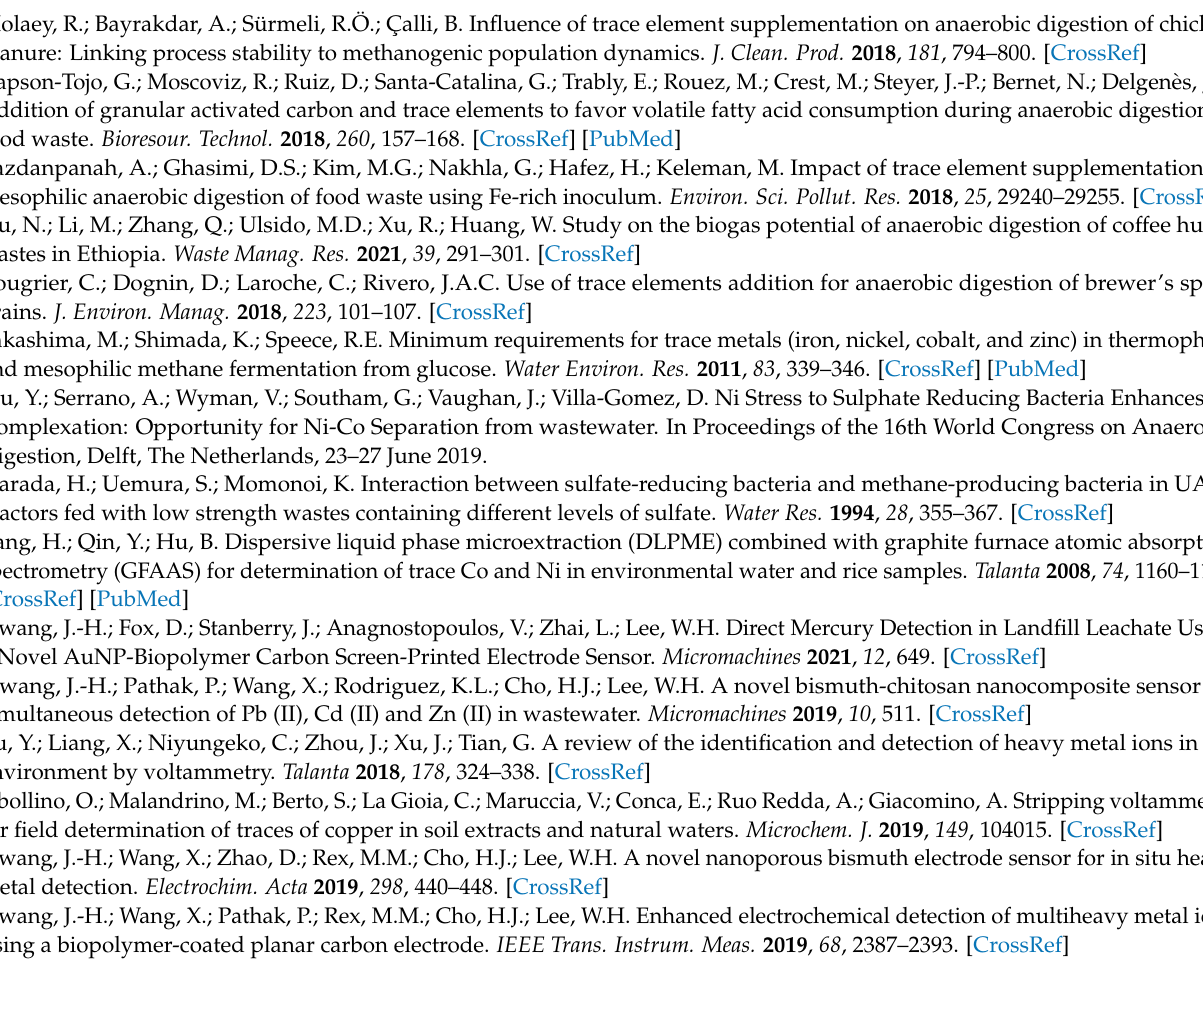
Ni(II) and Co(II) in the natural water samples; Table S1: Optimal SWAdCSV operational conditions for Ni and Co measurements using Bi-chitosan-GCE sensor; Table S2: Optimum values for fitted equivalent circuit elements for Bi-chitosan-GCE EIS measurement; Table S3: Summary of sensor performance in ammonia buffer solution and natural water